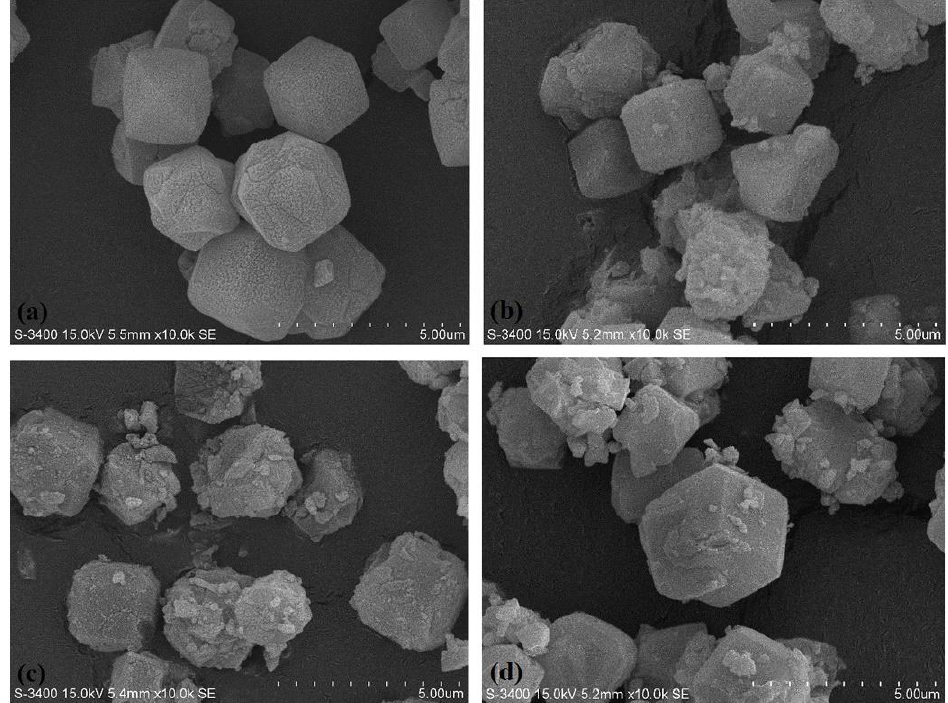
Figure 3. SEM images of NaX ( a ), CoX ( b ), ZnX ( c ), and AgX ( d ), reprinted from [45], with permission of